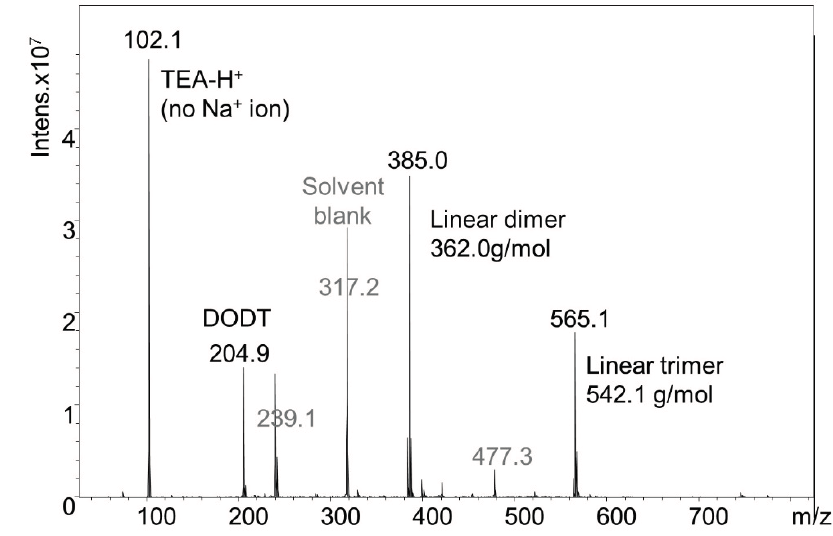
Figure 9. ESI-MS spectrum from the solution synthesis of cyclic species.